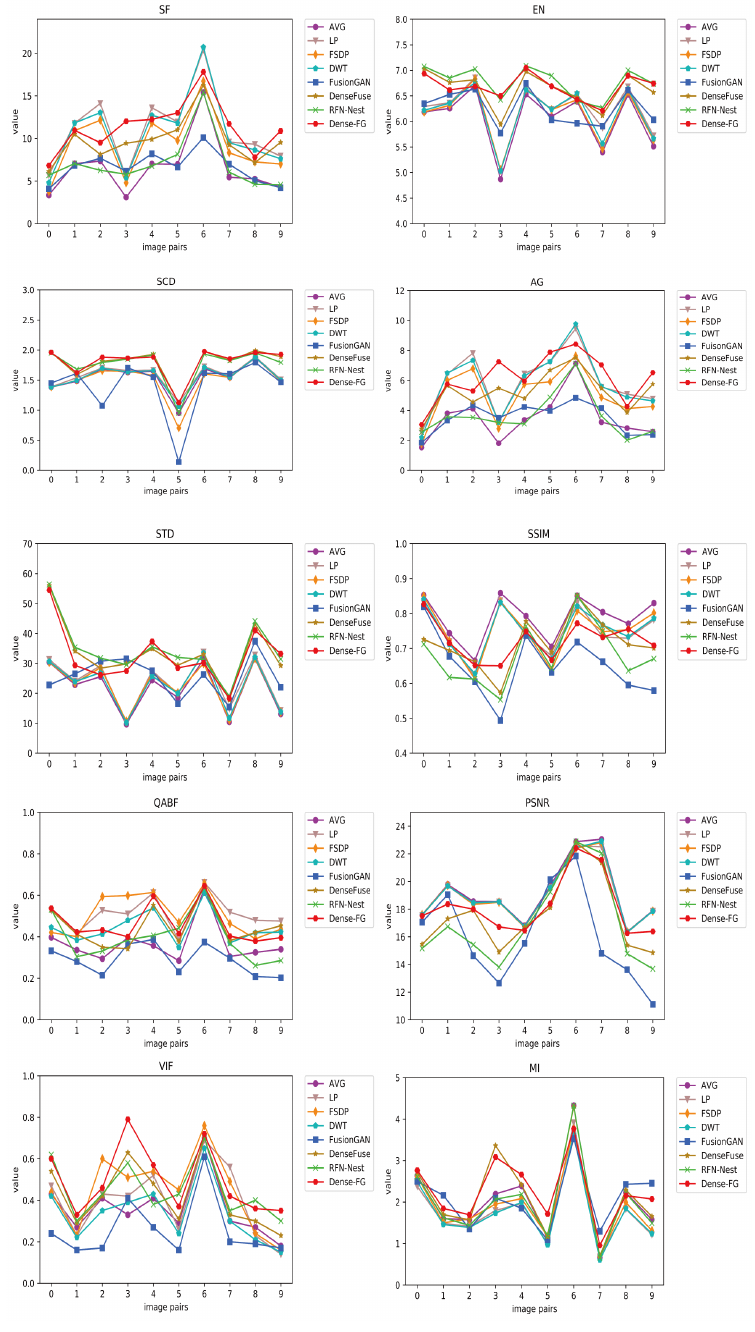
Figure 6. Objective evaluation of the fusion